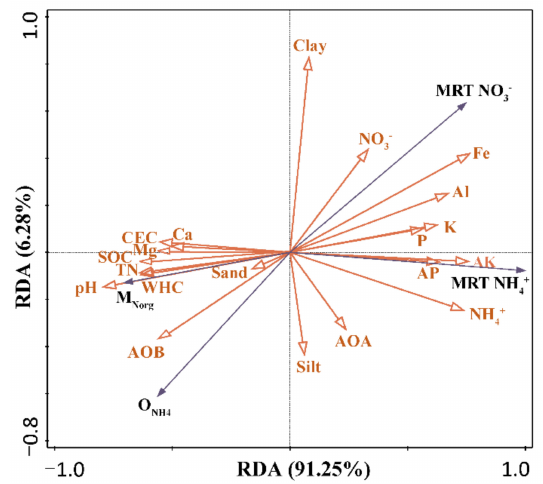
Figure 4. Redundancy analysis (RDA) of soil N-cycling rates, AOA and AOB abundance, and soil properties under woodland and pitaya